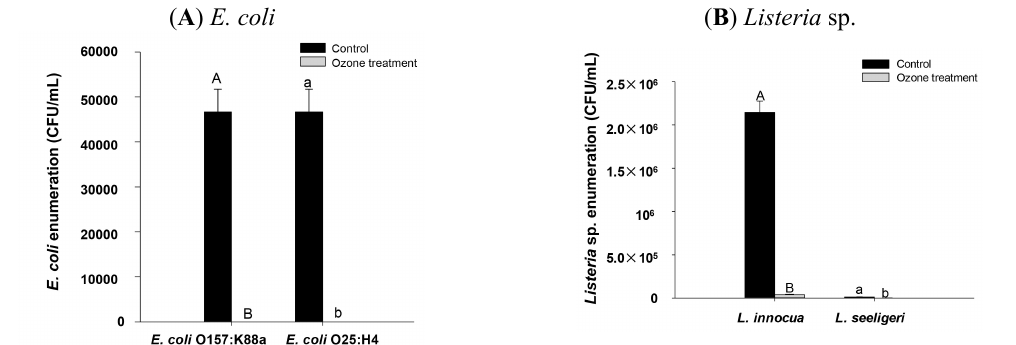
Figure 7. Impacts of ozone-enrichment on two strains of ( A ) E. coli and ( B ) Listeria sp. inoculated onto the surface of spinach leaves. Leaves were either treated with 10 ppm ozone concentration (grey bar) or untreated (black bar) for 2 min. Colonies were enumerated after nine days of storage. Values represent means (±Standard Error) of measurements made on three independent spinach leaves per treatment. Bars with different letters are significantly different ( p < 0.05).